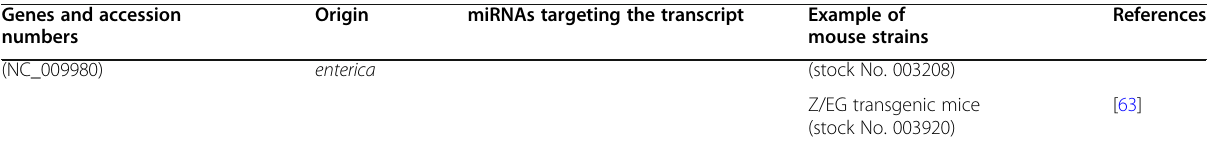
Table 1 Mus musculus miRNAs against inserted foreign genes and corresponding transgenic mice. Reporter genes like Neo r , LacZ, Cre recombinase, DsRed, and TdTomato have widely been used to generate transgenic mice. However, due to their non- mammalian origin, (e.g., DsRed from Discosoma sp. , GFP from Aequorea victoria , and LacZ from Escherichia coli K12), most of these genes may be potentially targeted by Mus musculus miRNAs once expressed in transgenic mice